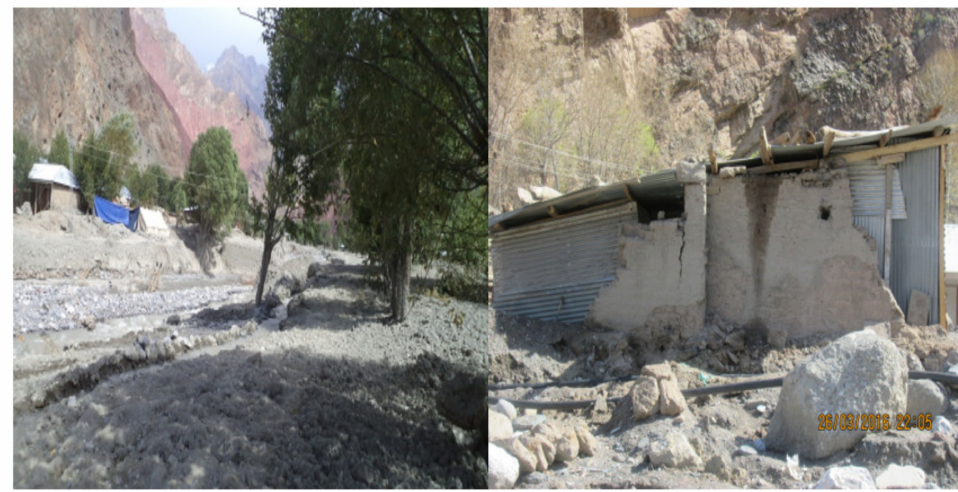
Figure 2. Damage caused by a flash flood in Chitral.